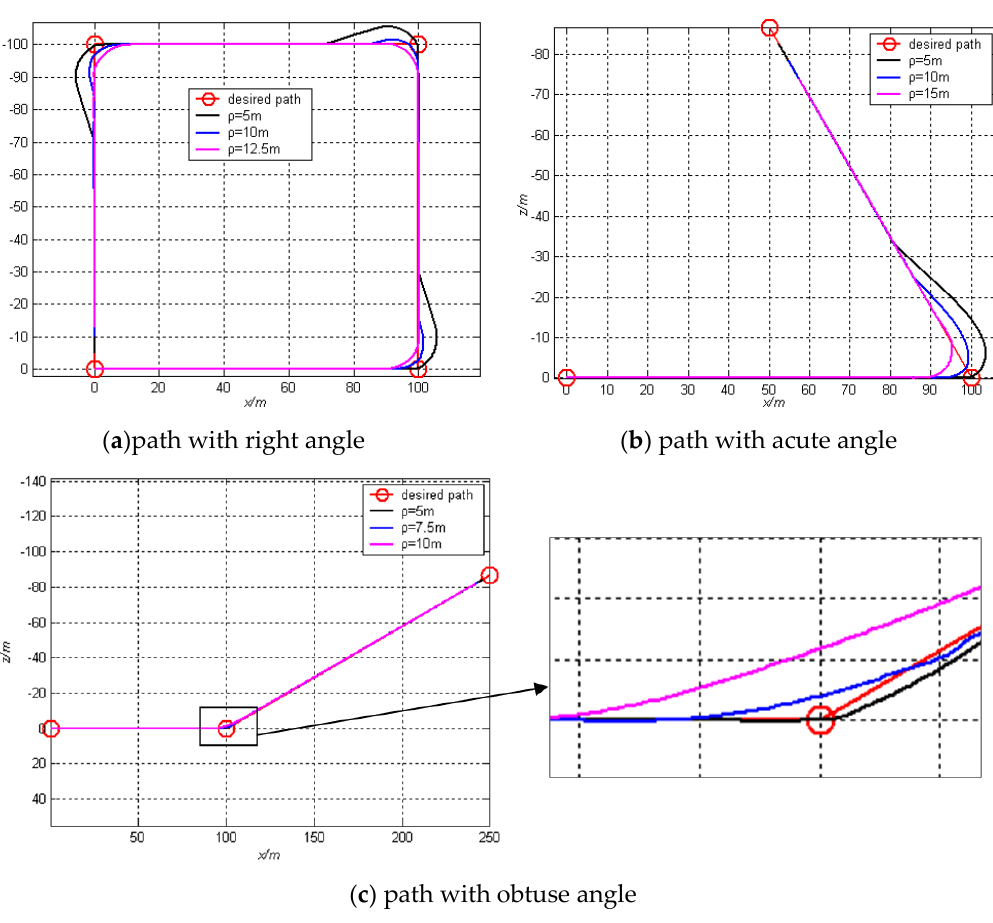
ff erent acceptance